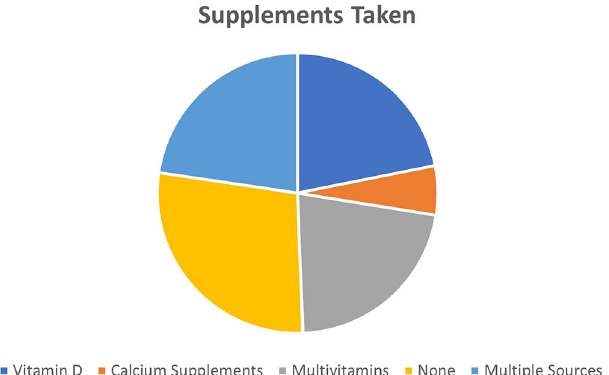
Figure 2. Supplementation intake among the study